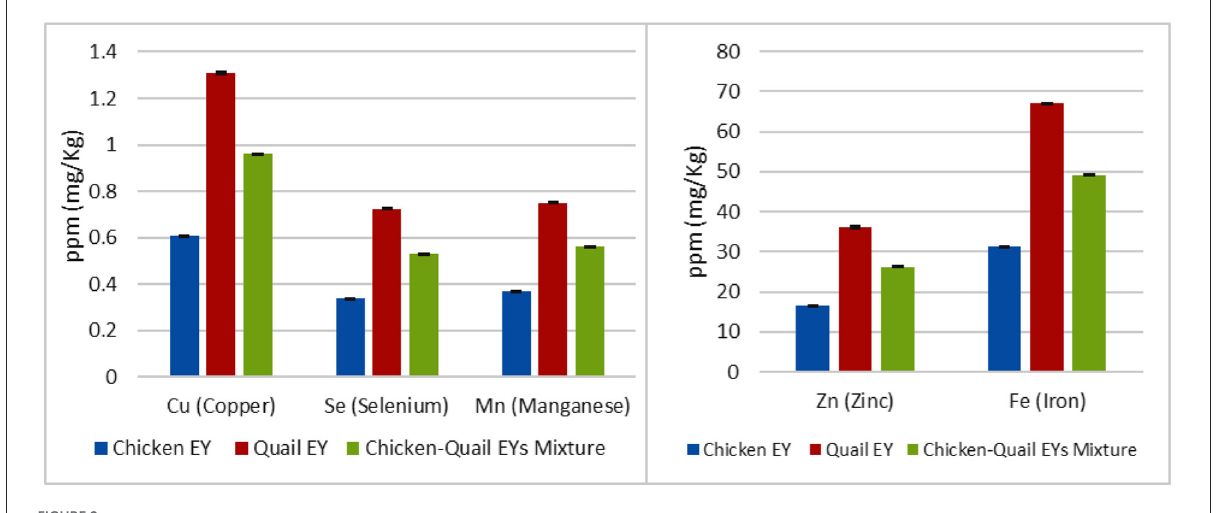
FIGURE2 The Cu (Copper), Zn (Zinc), Fe (Iron), Se (Selenium) and Mn (Manganese) concentrations (mg/kg) in the chicken, Japanese quail egg yolk (EY) and their